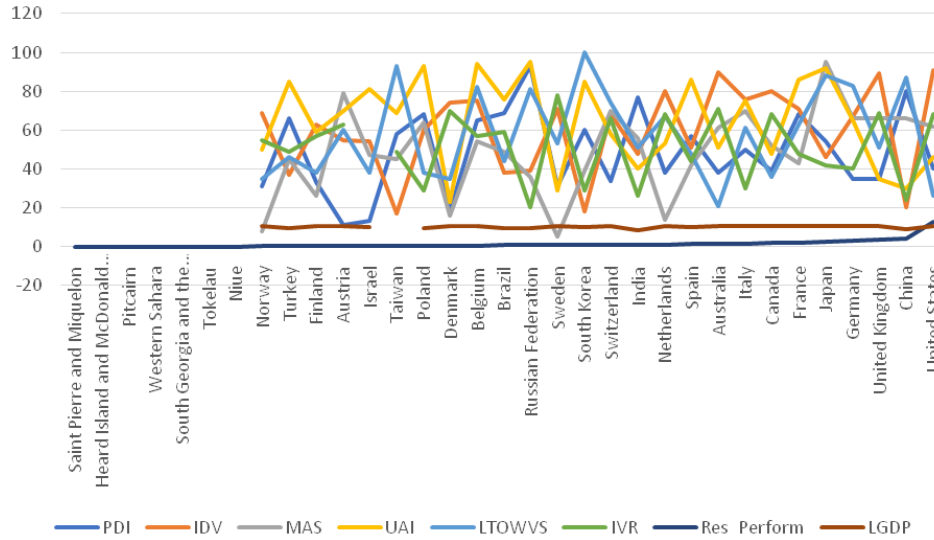
Figure 2. Plots of national cultures, research output, and Log GDP per capita. PDI = Power distance; IDV = Individualism; MAS = Masculinity; UAI = Uncertainty avoidance; LTOWVS = Long term orientation; IVR = Indulgence; Res_Perform = Research Output; LGDP = Log GDP per